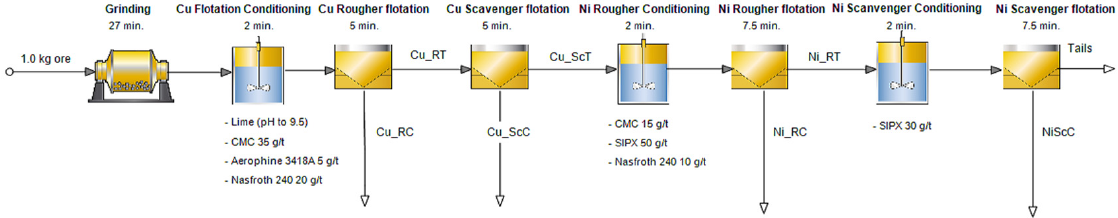
Figure 2. Particle size distribution for the ground flotation feed on a logarithmic scale.